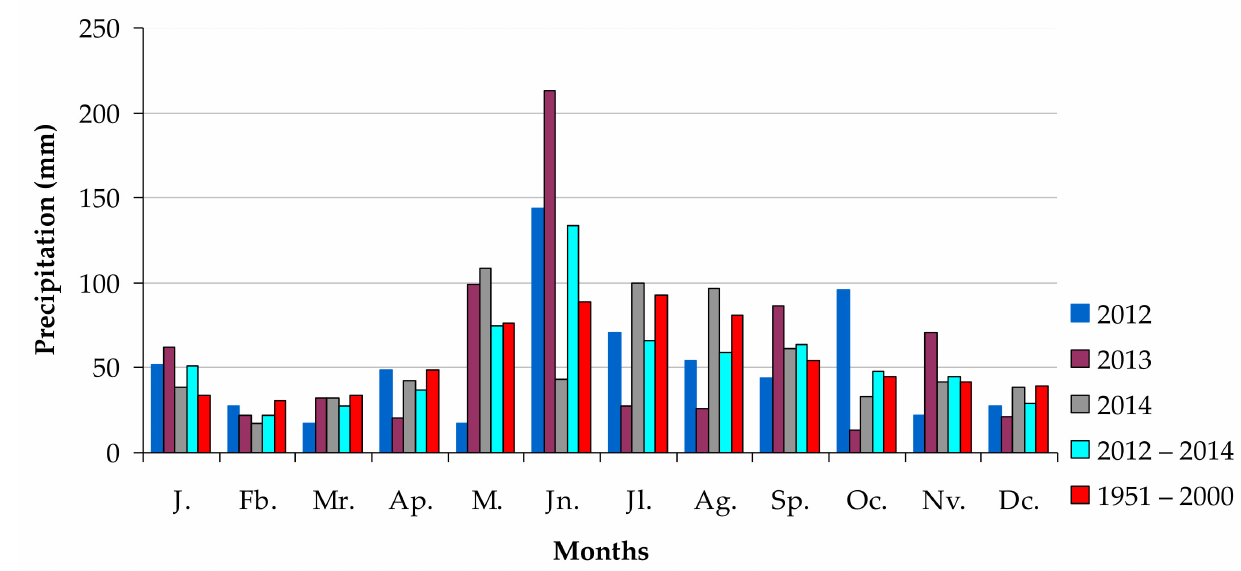
Figure 2. Sum of precipitation (mm) during the study.